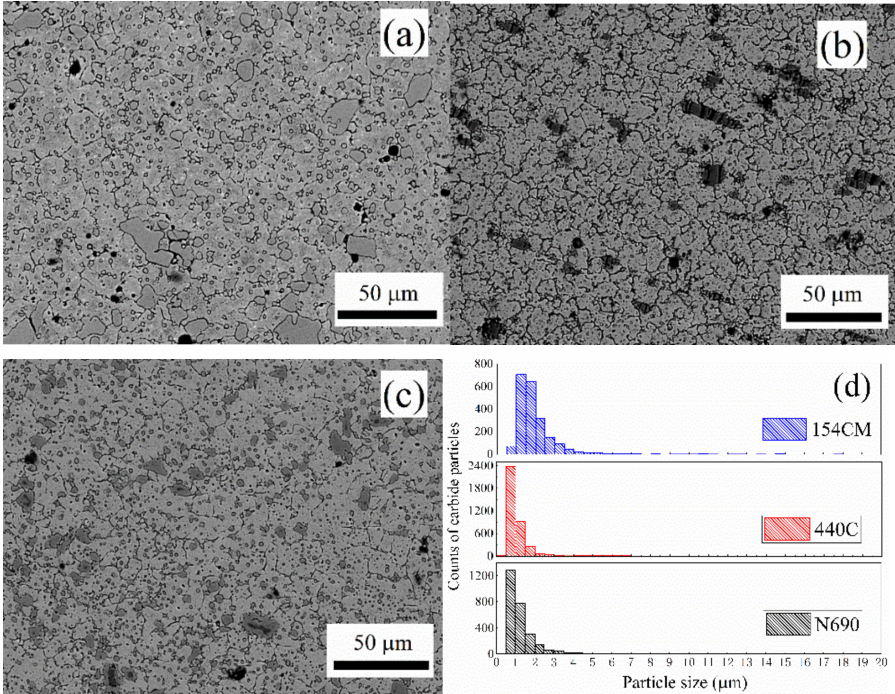
Figure 7. Microstructure of the martensitic stainless steels ( a ) 154CM, ( b ) 440C, and ( c ) N690 imaged by backscattered electron and the distribution of carbide particles in these three steels ( d